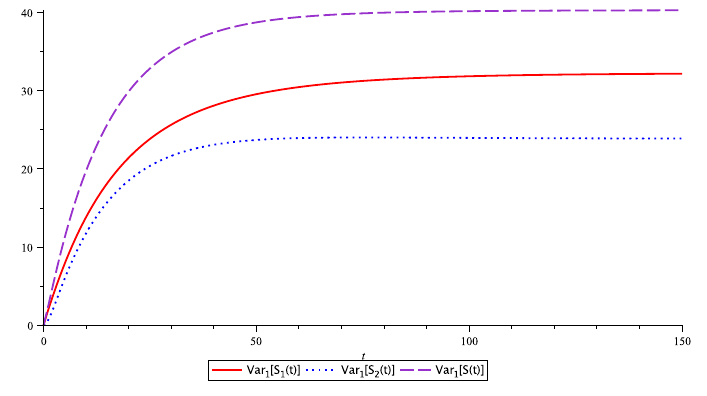
Figure 1. Variances of S ( t ) , S 1 ( t ) and S 2 ( t ) with initial state J ( 0 ) = 1. Table 2. Covariances of discounted claims at t and t + 1.